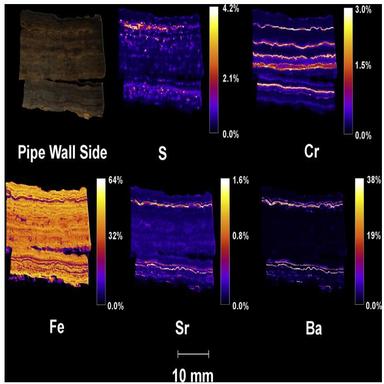
Micro-XRF mapping of sample 3.